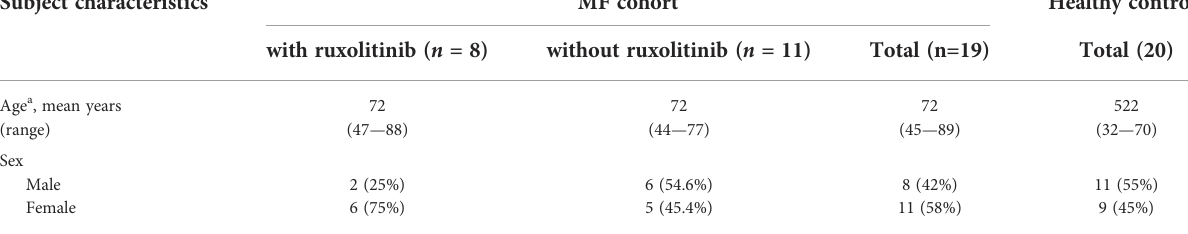
TABLE 1 Demographic characteristics of myelo fi brosis (MF) patients and healthy